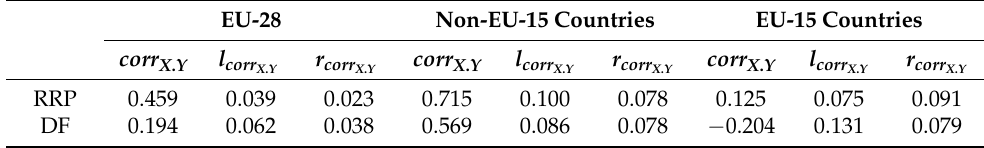
Table 11. Correlations of SER with RRP and DF efficiency index.